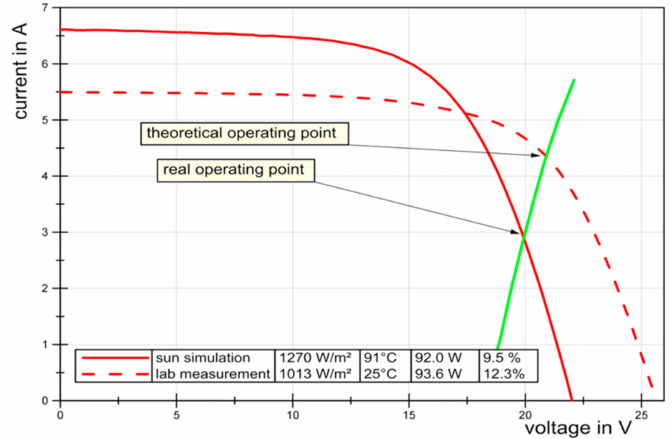
Figure 10. Comparison of realistic (sun simulation) and laboratory conditions with the corresponding PV current voltage curves represented by continuous and dashed lines, respectively. The performance of the 12-cell electrolyser stack is the solid green line.